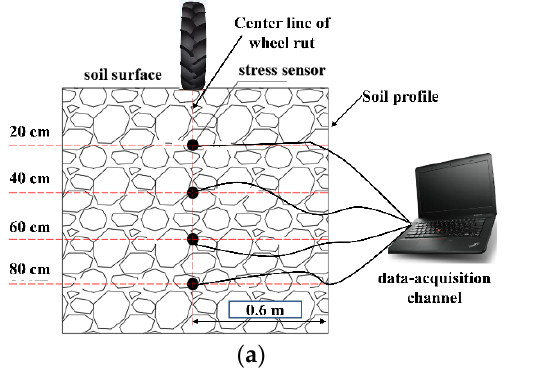
Figure 2. Soil stress measurement. ( a ) Sensor installation diagram; ( b ) stress data acquisition process.